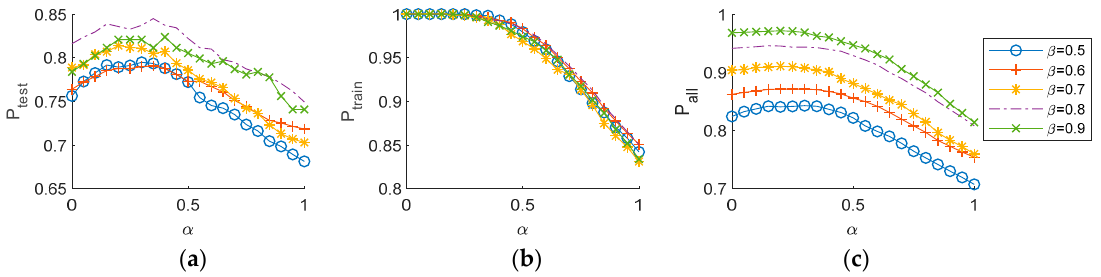
Figure 7. The curve of recognition accuracy P with weight α at different β . ( a ) The accuracy of the test set; ( b ) The accuracy of the training set; and, ( c ) The accuracy of all images. As can be seen from Figure 7a, when α is between 0.2 and 0.4, the proposed algorithm has the